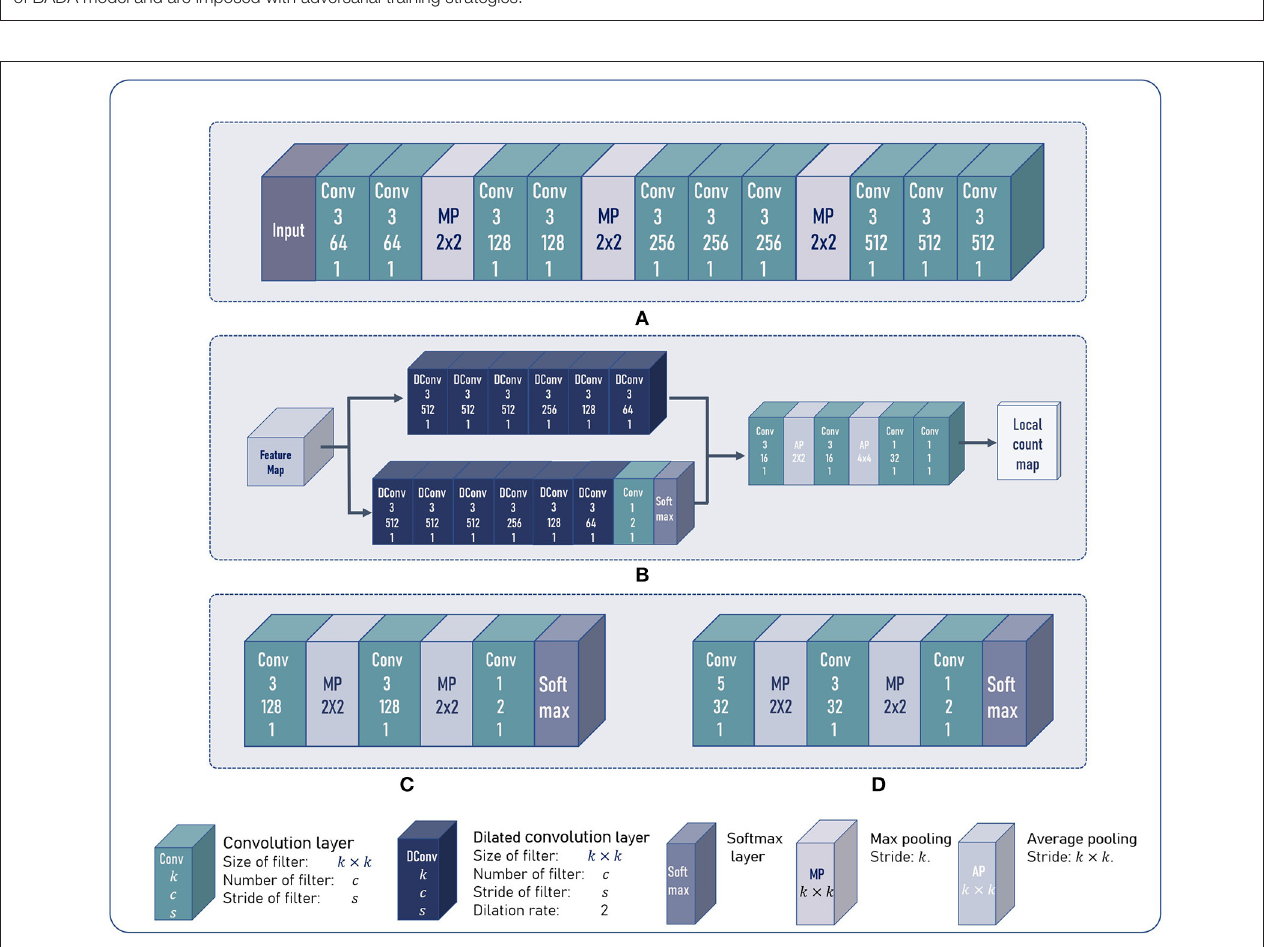
FIGURE 5 | The architecture of our model. (A) The architecture of the feature encoder. (B) The architecture of the multi-branch decoder and the local count regressor. (C,D) The architecture of the feature discriminator and the foreground mask discriminator.